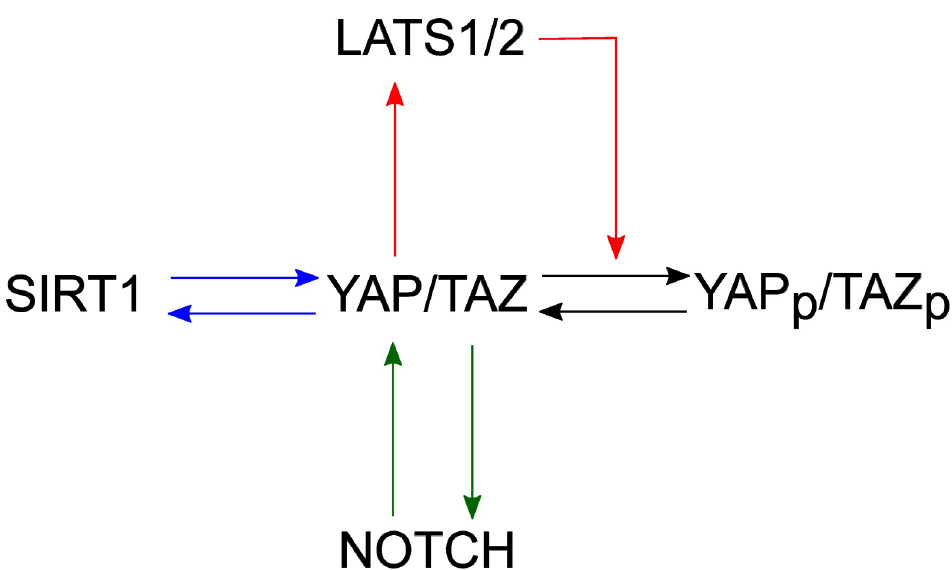
Fig 1. Schematic depiction of the regulatory network of YAP/TAZ. LATS1/2 promotes the phosphorylation of YAP/ TAZ [1–6], leading cytoplasmic accumulation and subsequent degradation of YAP/TAZ while YAP/TAZ promotes the transcription of LATS2 [7]. YAP/TAZ promotes the Notch signaling pathway by inducing transcription of JAG1, DLL1, and RBPJ [8, 9], while Notch signaling pathway promotes YAP/TAZ expression through RBPJ-binding to YAP1 promoter [8, 9]. SIRT1 promotes YAP through Pol II-dependent transcription [12], while YAP/TAZ promotes SIRT1 transcription by upregulating MYC [13, 14].